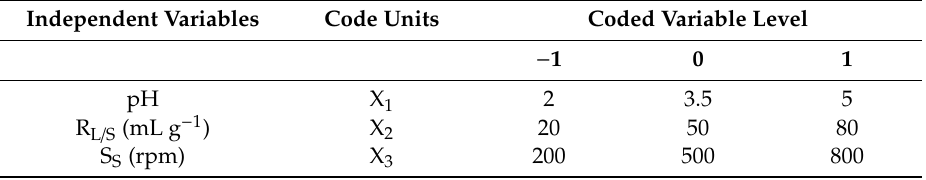
Table 1. Actual and coded levels of the process variables considered for response surface optimization. Independent